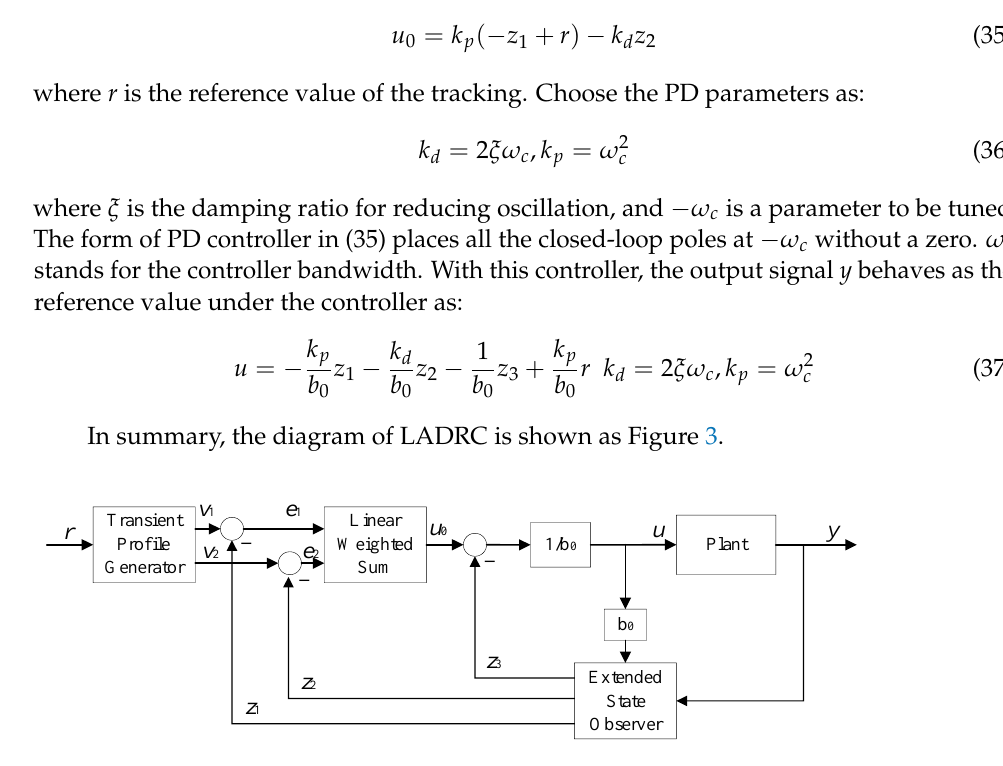
Figure 3. The diagram of LADRC system.